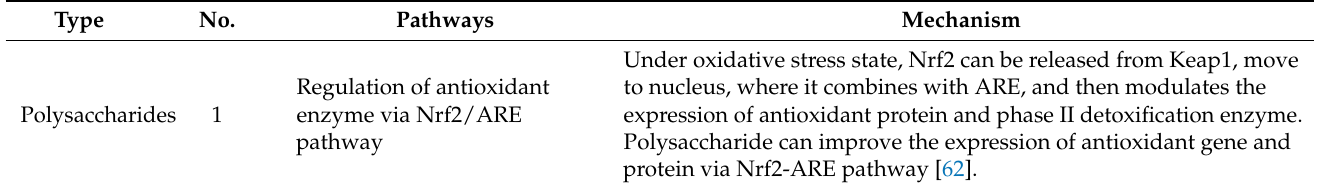
Table 1. Four representative plant extracts and their potential action mechanisms on both oxidative stress and inflammation related